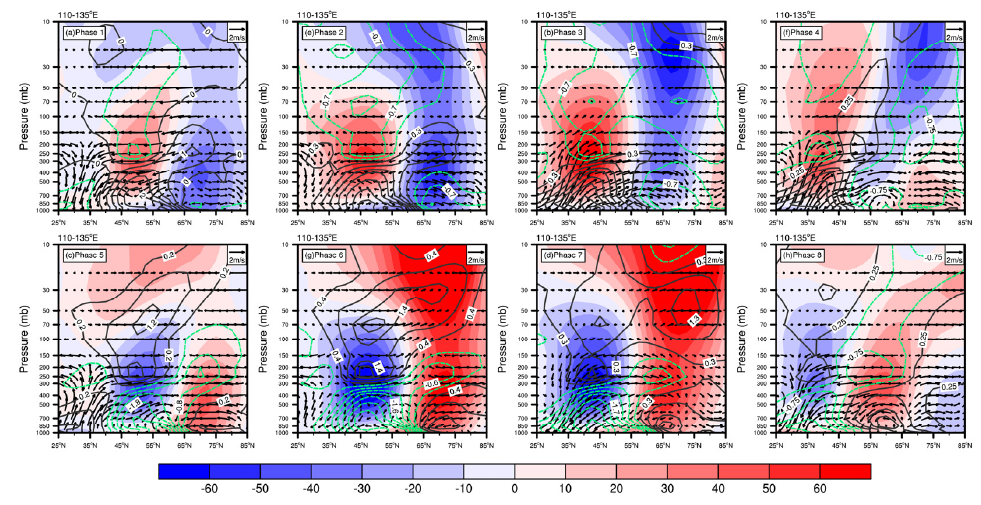
Figure 8. The vertical-meridional cross section of 10–30 d filtered geopotential height (shading; unit: gpm), temperature (contour; unit: °C; green contours indicate the negative values), and wind (vector; meridional wind unit: m s − 1 , vertical velocity unit: − 10 2 Pa s − 1 ) averaged along the longitudes 110–135° E during LECEs.